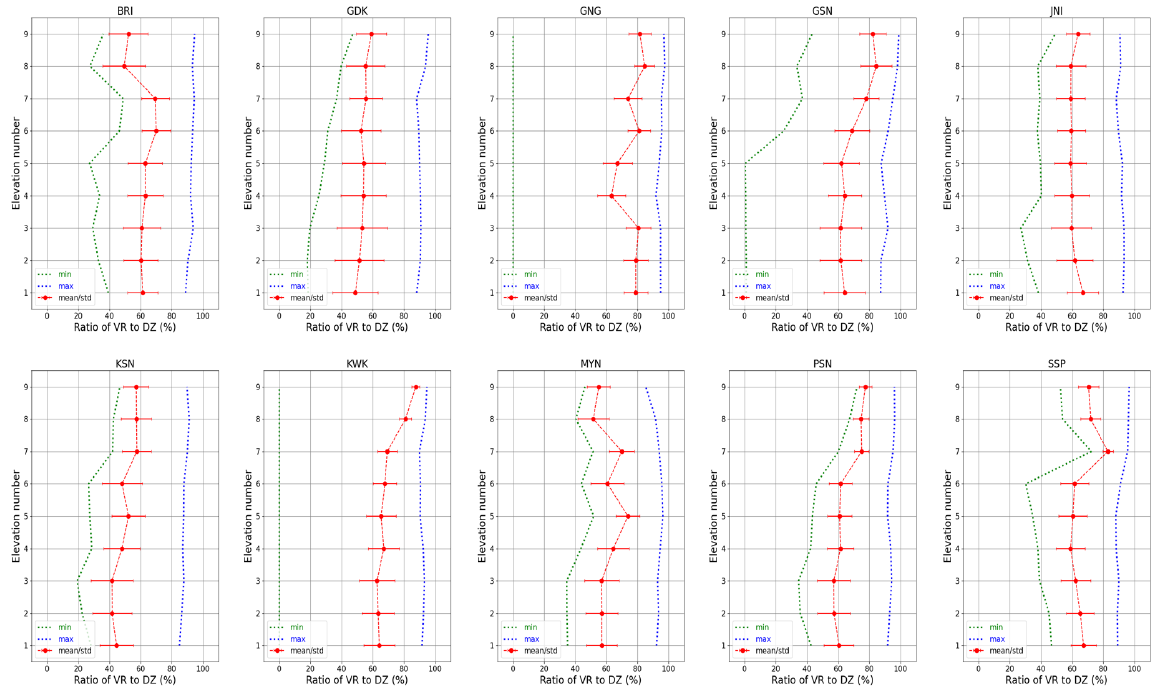
Figure 2. Ratio of radar bins with radial velocity (VR) observation to radar reflectivity (DZ) observation as a function of elevation angles for August 2020 from KMA’s ten weather radars (BRI, GDK, GNG, GSN, JNI, KSN, KWK, MYN, PSN, and SSP). The red dots and bars represent the average ratio and standard deviations, respectively. The blue and green dotted lines indicate the maximum and minimum ratios at each elevation angle, respectively.